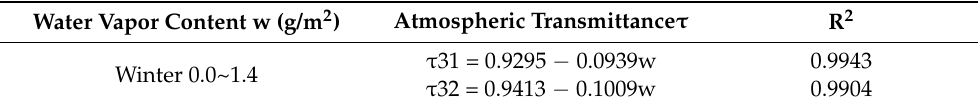
Table 1. Relationship between atmospheric transmittance and water vapor content. Water Vapor Content w (g/m 2 )